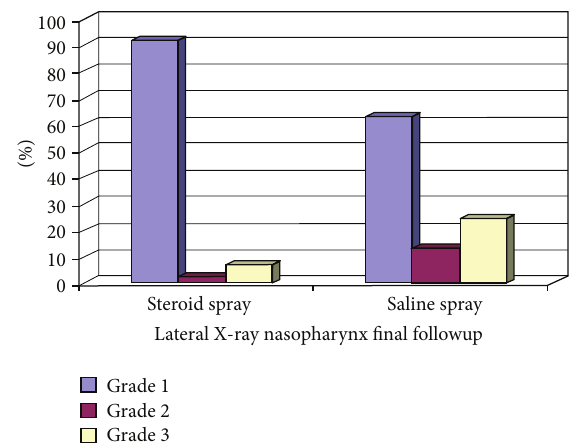
Figure 2: Description of X-ray findings among steroid and saline patients at the last followup, 1 year postoperatively. This graph shows the differences between patients as regards the adenoid enlargement grade between both study groups after 1 year (Grade 1 = > 6mm, Grade 2 = 4–6 mm, and Grade 3 =